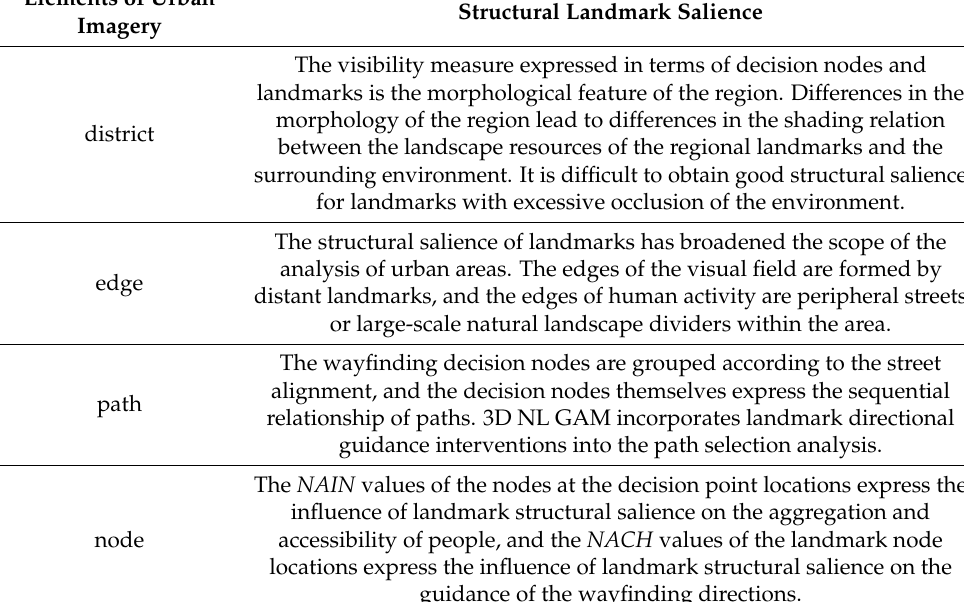
Table 5. The relationship between the structural salience of landmarks and the other four elements of the